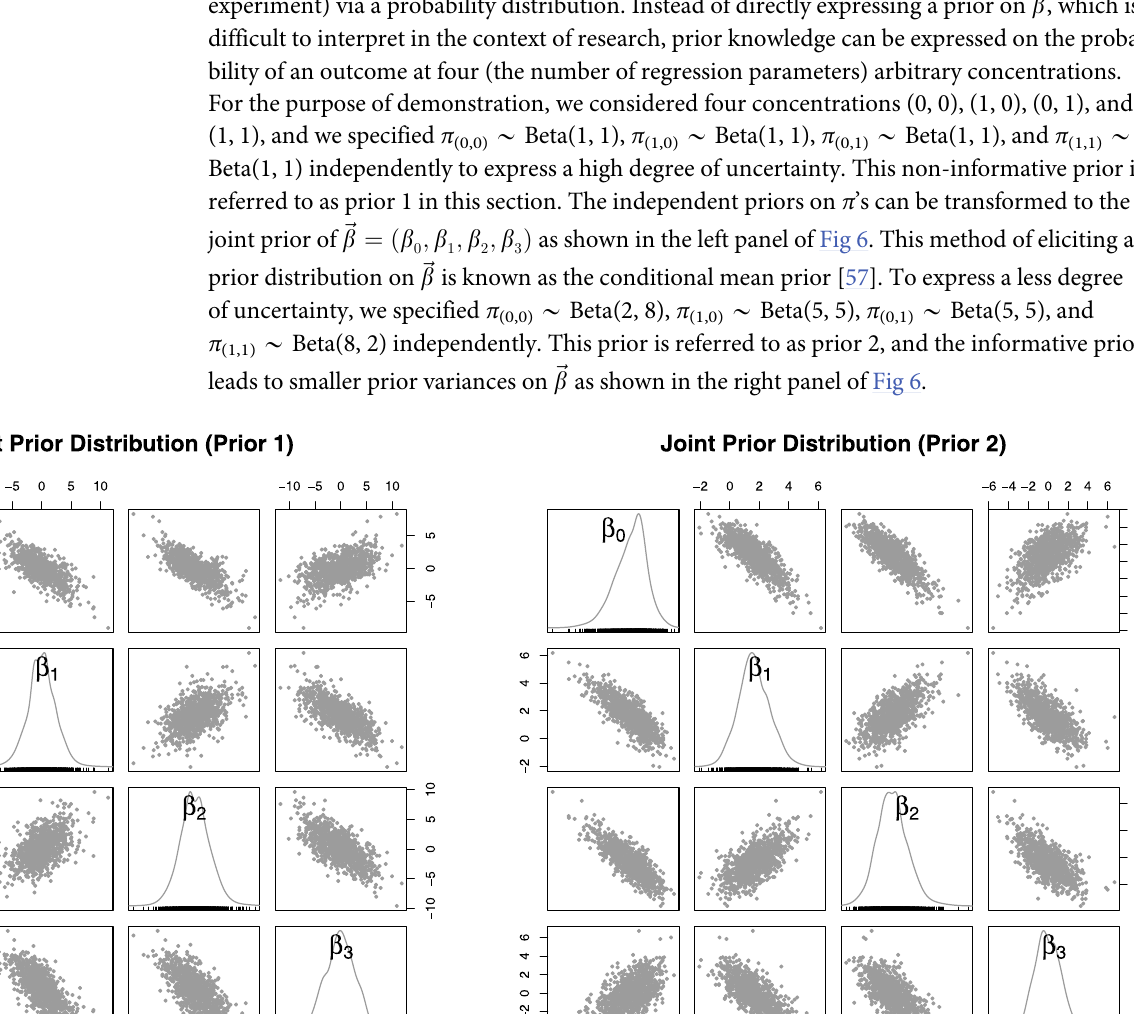
; b ; b ; b Þ induced from the 0 1 2 3